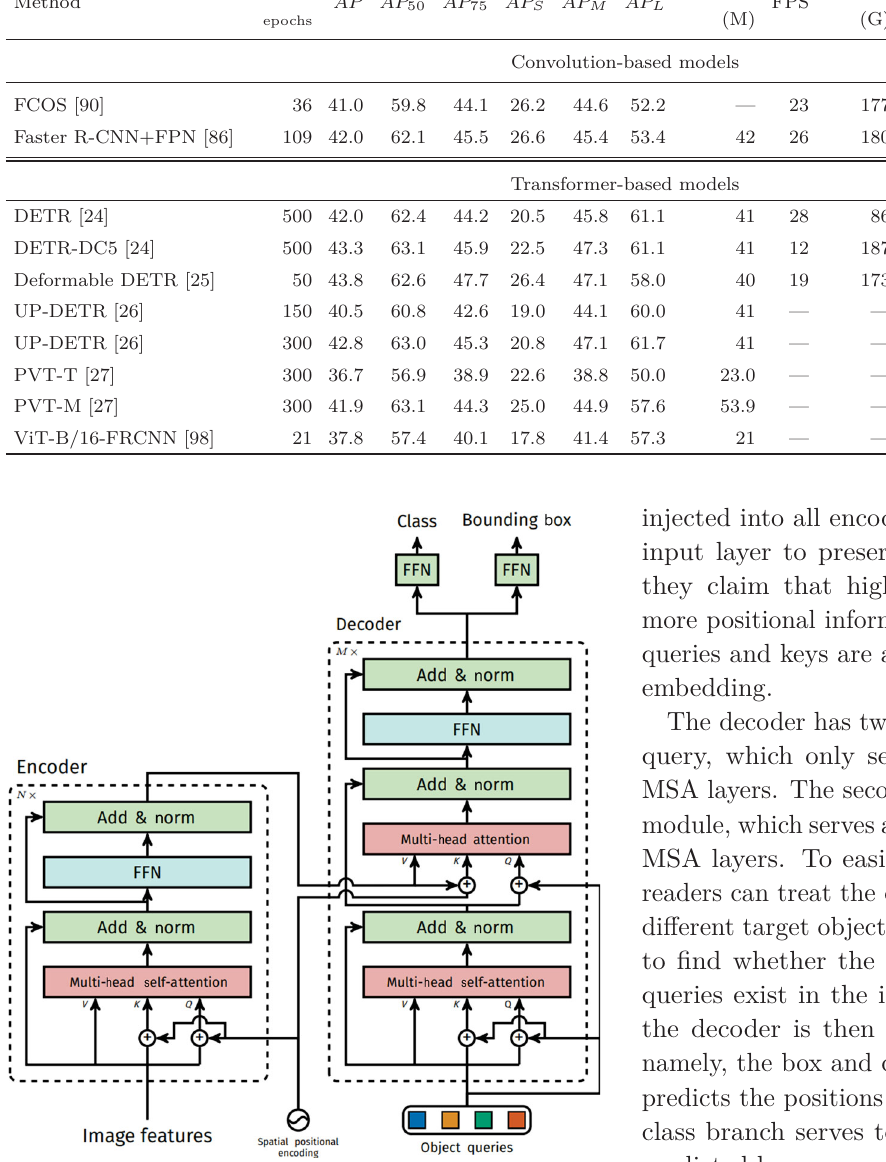
Table 3 Comparison of transformer-based detection models on the COCO 2017 val set Method